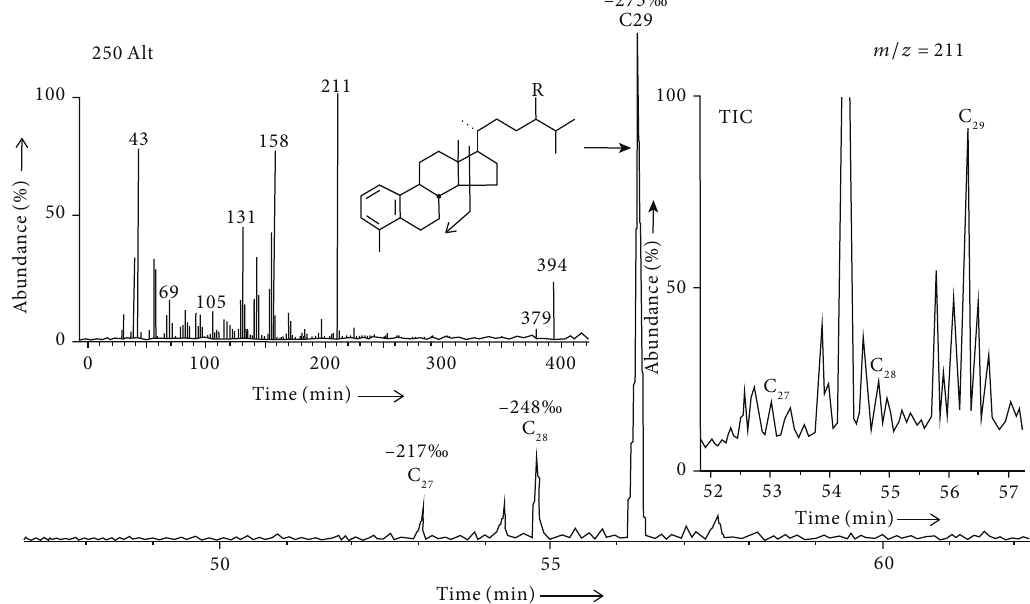
Figure 2: Molecular and isotopic distributions of ring A monoaromatic steroids in the 250Alt